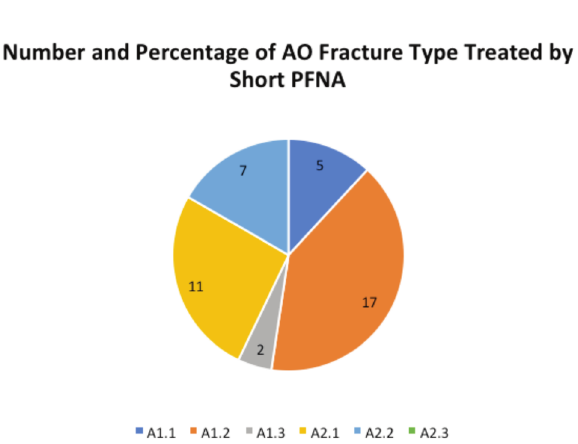
Number and Percentage of AO Fracture Type Treated by Fig. 2: Short